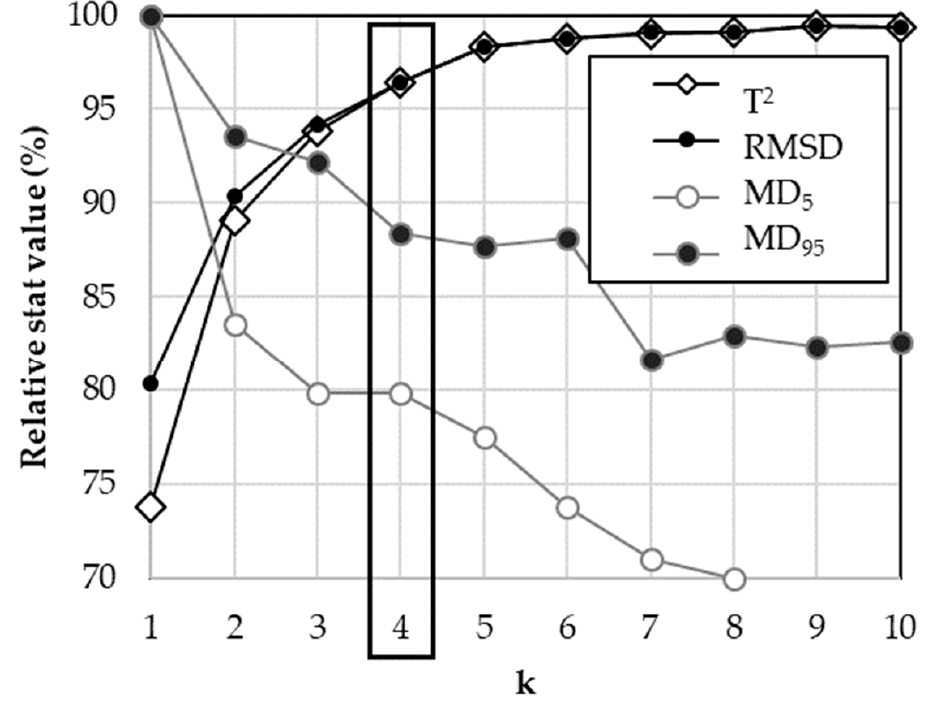
Figure 5. Percent statistic values relative to their optimal values (100%) across a range of k values (rel stat_opt ) for pseudo-R 2 (T 2 , Equation (2)), root mean square difference (RMSD, Equation (3)), and mean difference using the lower and upper 5% of distribution (MD 5 , MD 95, Equations (5) and (6)), supporting the selection of the optimal k value of 4.